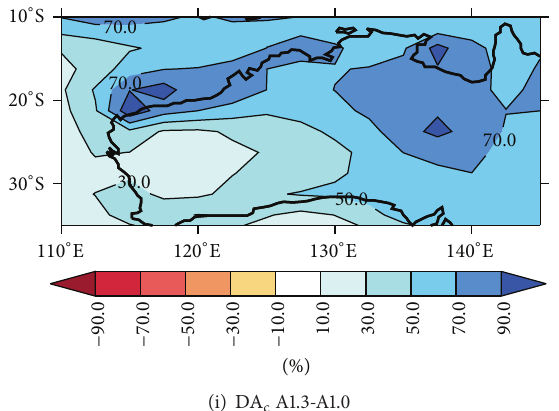
Figure 8: The climatological mean (1979–2001) DJF precipitation (mm day −1 , colored contours) and fractional cloud cover (solid black lines) from (a) A1.0, (b) A1.1, and (c) A1.3. The percentage difference in precipitation for (d) A1.1 relative to A1.0, (e) A1.3 relative to A1.1, and